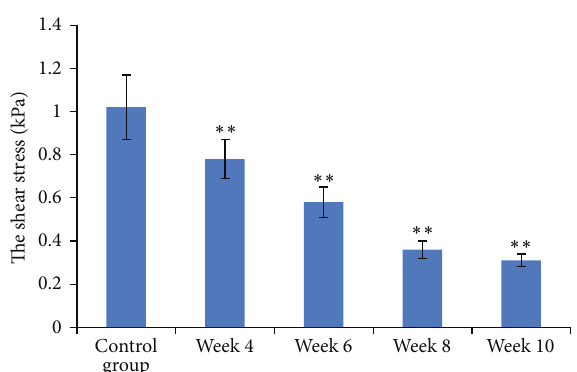
Figure4:NOSactivityinportalvenousblood.Resultsareexpressed as means ± SD, ∗ 𝑃 < 0.05 and ∗∗ 𝑃 < 0.01 versus the control group.